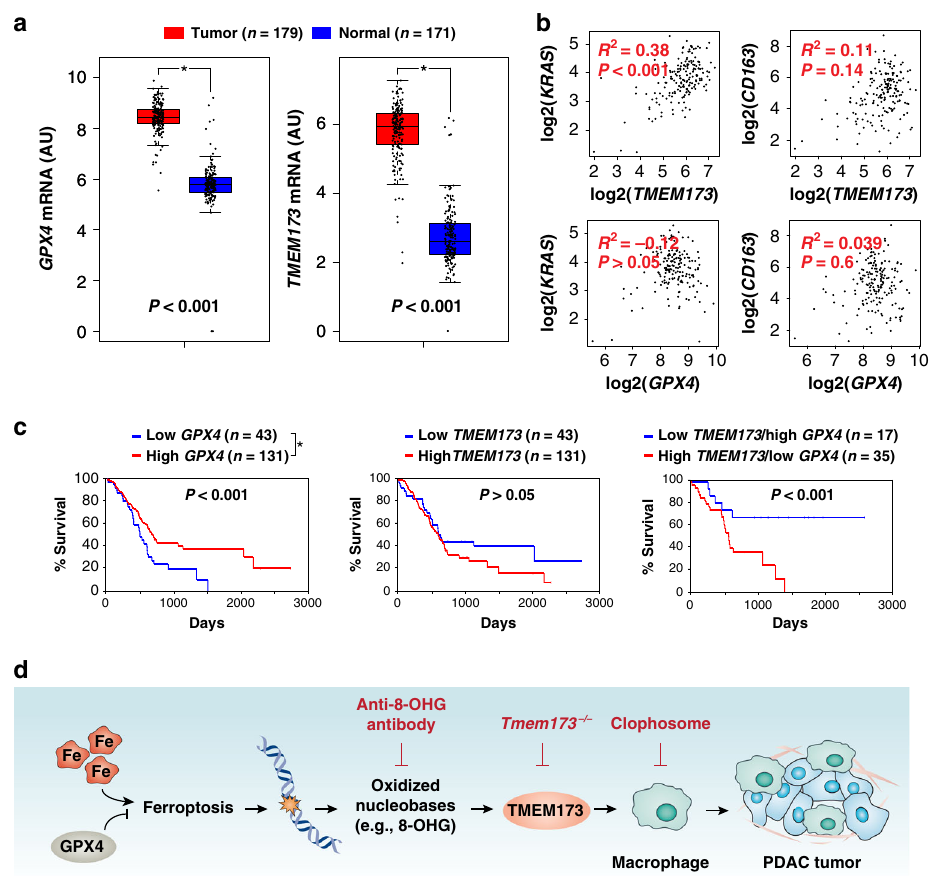
Fig. 6 GPX4 is a prognostic marker in human PDAC. a Upregulation of GPX4 and TMEM173 gene expression within the tumor from PDAC patients compared to normal controls using datasets from The Cancer Genome Atlas (TCGA) (* P < 0.001; one-tailed t test). The data are presented as box-and- whisker plots. Boxes represent the median and the 25th and 75th percentiles. b Pearson correlation assay between KRAS , CD163 , TMEM173 , and GPX4 gene expression in PDAC patient TCGA datasets. c Kaplan – Meier survival analysis with one-sided log-rank test of GPX4 and TMEM173 gene expression in PDAC patients using TCGA datasets. d Schematic depicting the role of high-iron diets or Gpx4 depletion in Kras -driven PDAC. The induction of ferroptosis